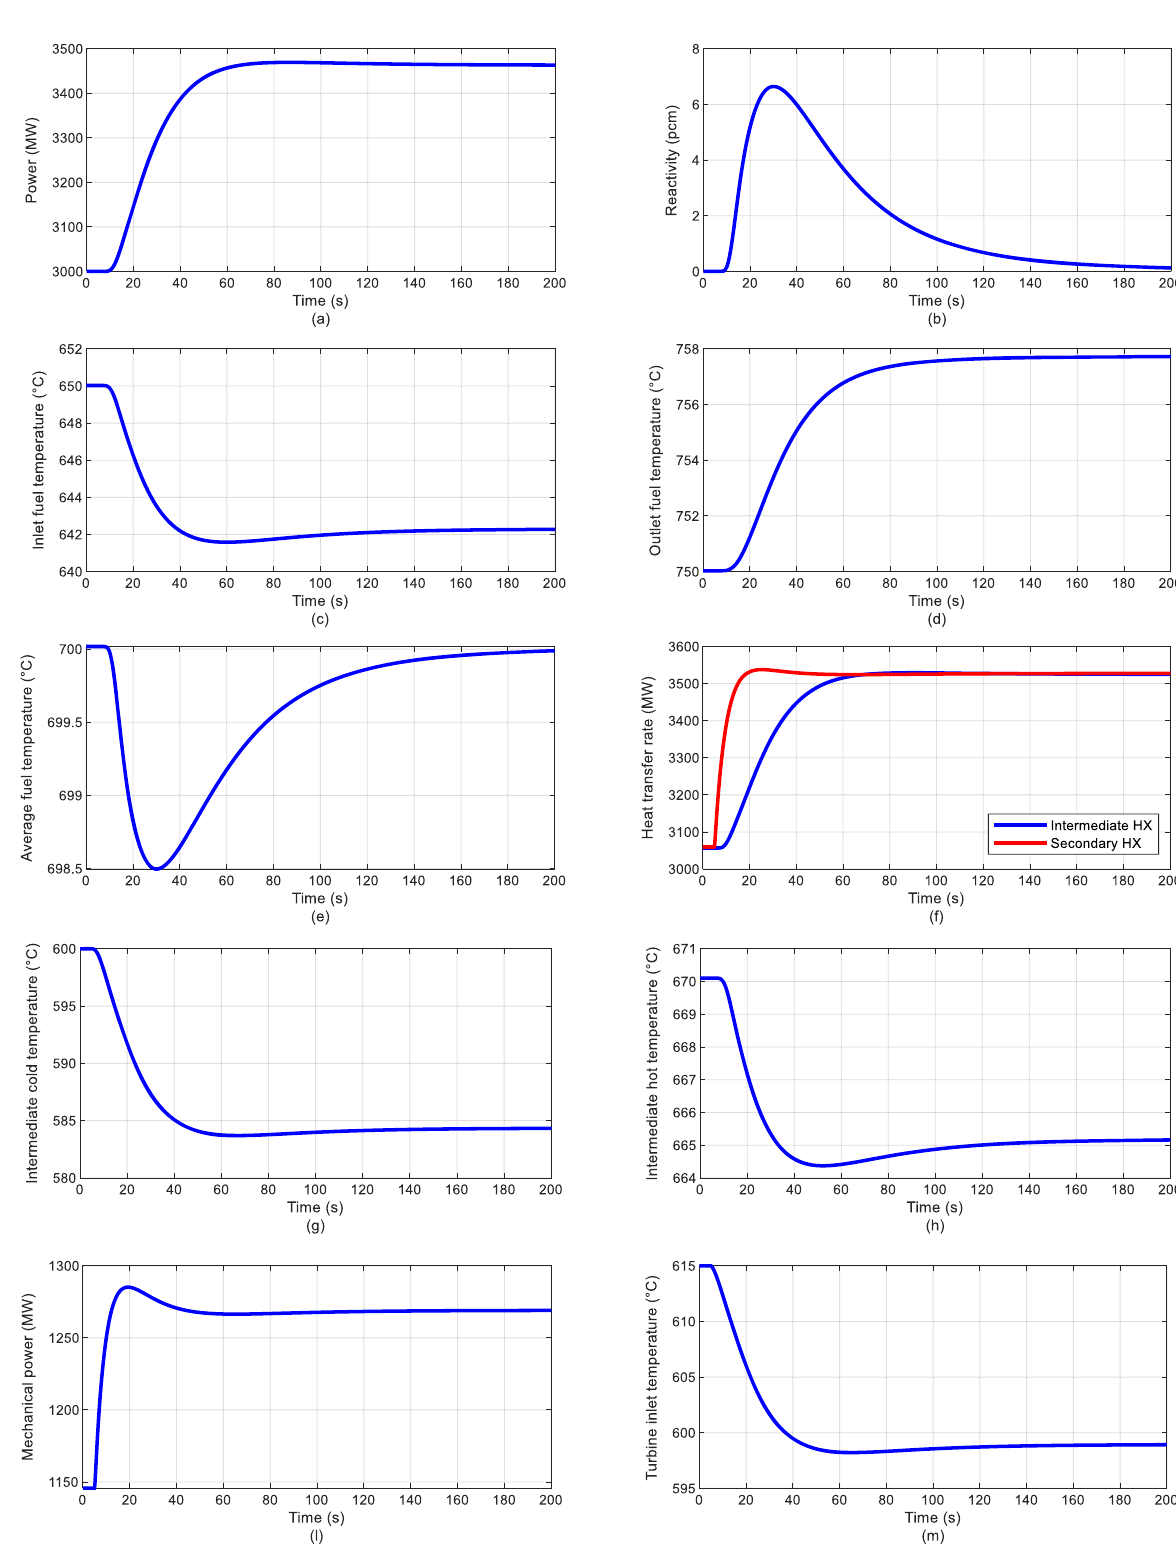
Fig. 15. Controlled variables evolution for 20% increase of the turbine helium mass fl ow rate: (a) reactor thermal power; (b) net reactivity variation; (c) fuel inlet temperature; (d) fuel outlet temperature; (e) fuel average temperature; (f) heat transfer rates in the heat exchangers; (g) intermediate salt minimum temperature; (h) intermediate salt maximum temperature; (i) turbine mechanical power; (m) helium turbine inlet